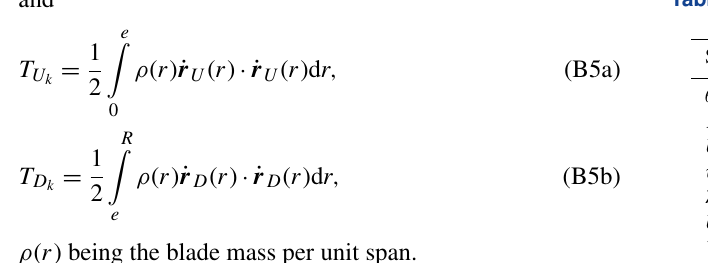
and Table B1. Definitions of the symbols in the aerodynamic